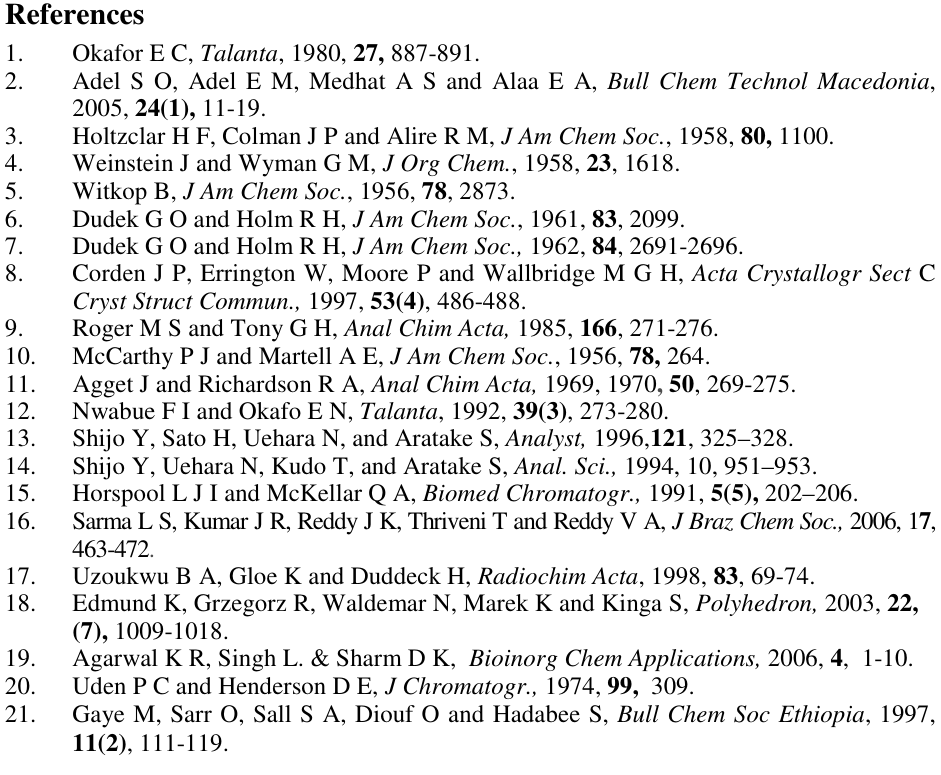
Table 5. Proton resonance data for the ligand in CDCl internal reference Signal, ppm Assignment 10.60 (br) 2